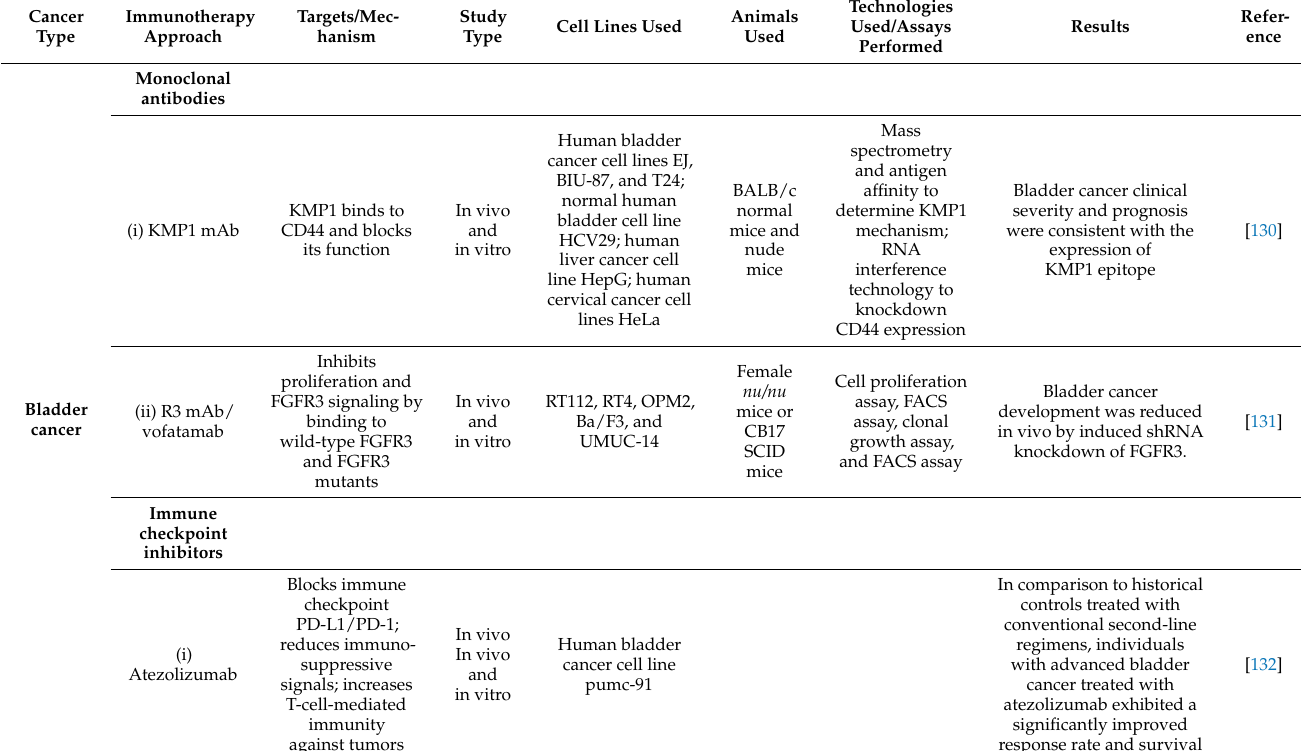
Table 1. Immunotherapies for cancer